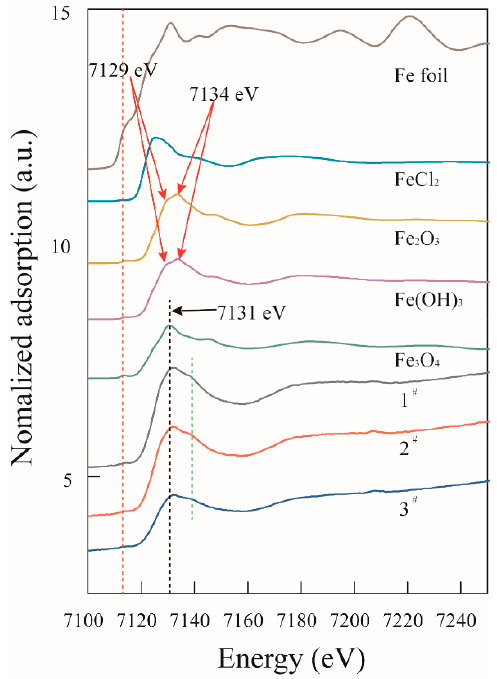
Figure 8. X-ray absorption near edge structure (XANES) spectra of bacteria cultured in media 1 # , 2 # , and 3 #